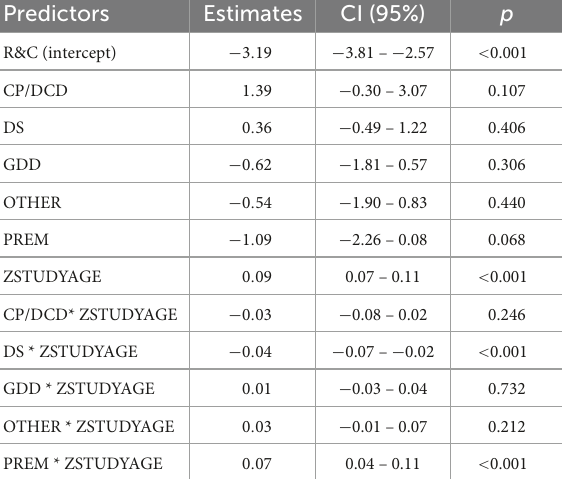
TABLE 2 Diagnoses as predictors of morpho-lexical scores (ZMORPHOLEX).